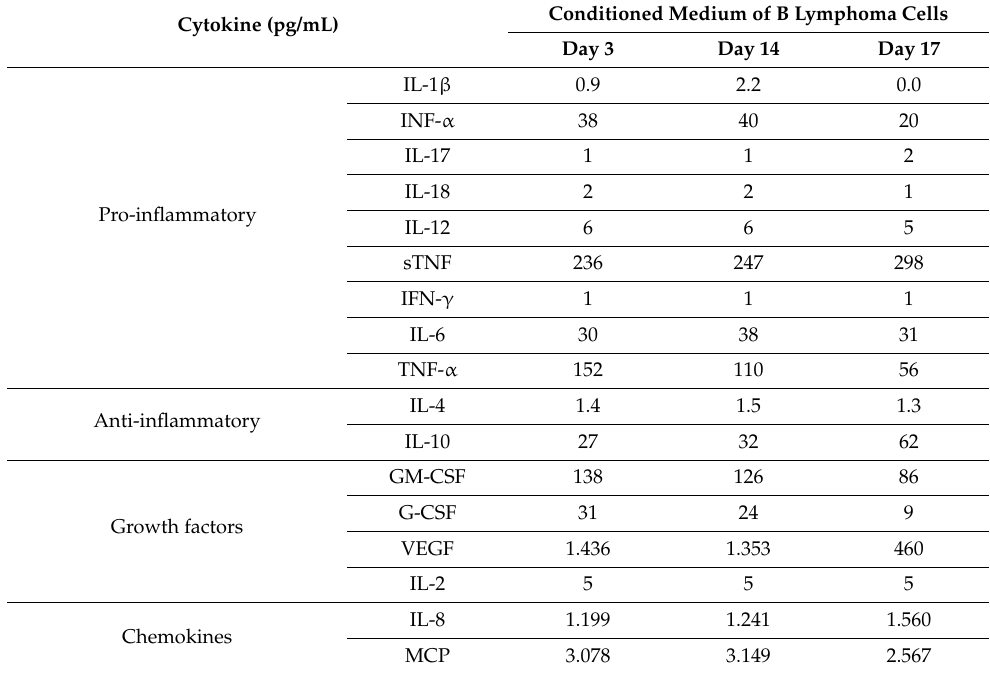
Table 1. Analysis of secreted cytokines contained in the conditioned medium of B lymphoma